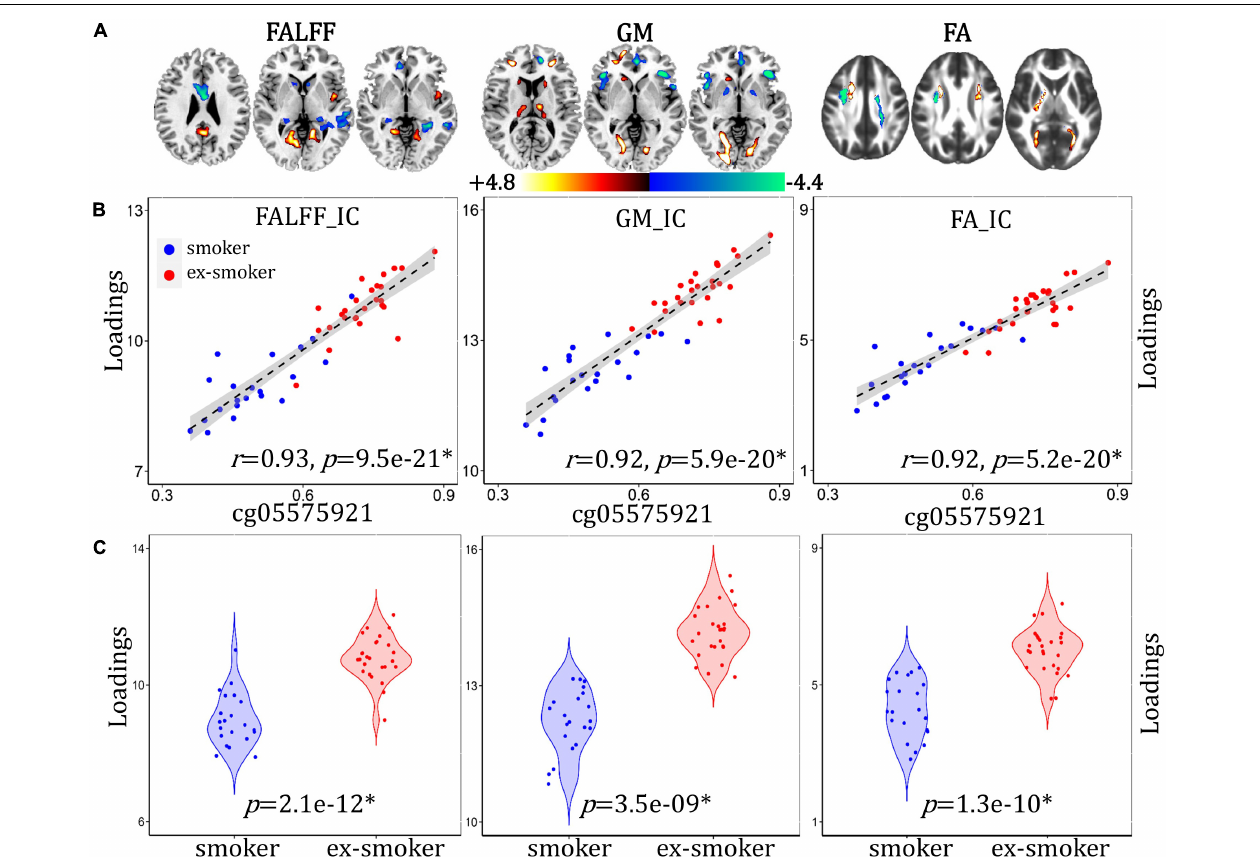
FIGURE 3 | Methylation-associated fALFF + GMV + FA multimodal joint components. (A) The spatial brain independent component (IC) networks visualized at |Z| > 2.5. Regions where smokers > ex-smokers indicated by blue color, regions where ex-smokers > smokers indicated by red color. (B) Correlations between components’ loadings and cg05575921 loci methylation. (C) Group difference of the components among smokers and